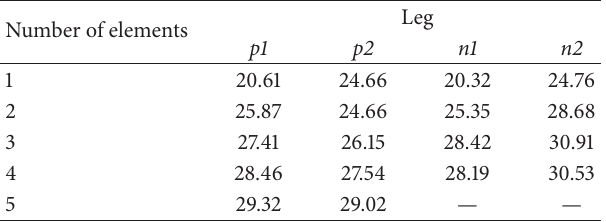
Table 5: Reduced efficiency of arrangements with increasing num- ber of